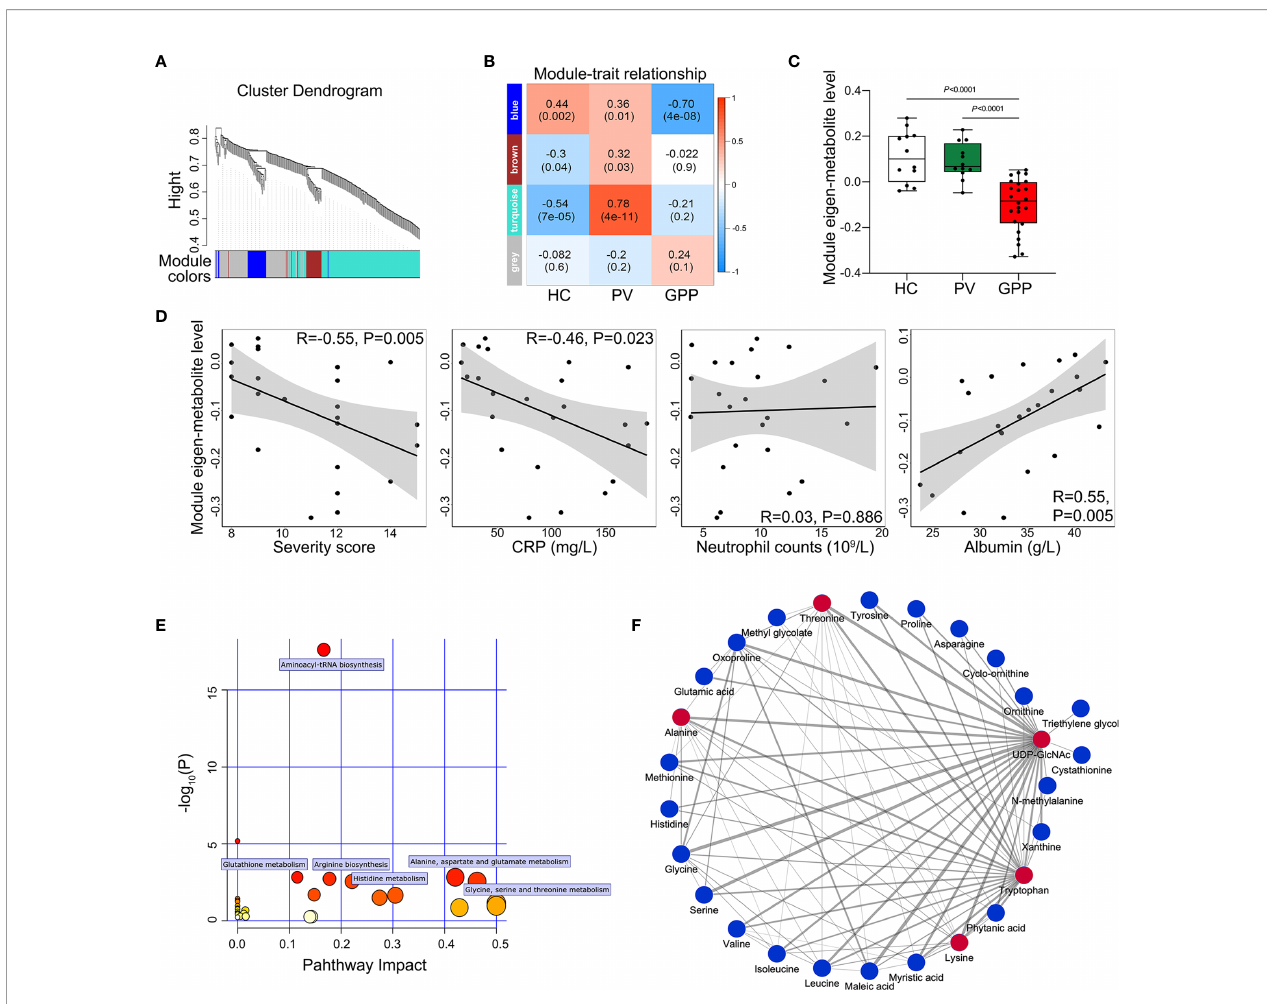
FIGURE 3 | Metabolite co-abundant network analysis. (A) Network cluster dendrogram constructed by hierarchical clustering of the metabolomic dataset. Three network modules were demonstrated in different colors. (B) Heatmap of the correlation between module eigen-metabolites and disease status. The heatmap cell color signi fi ed the correlation coef fi cients (red = positive, blue = negative). In the cells, the fi gure without parentheses showed the correlation coef fi cients. The P -values were indicated below in parentheses. (C) The eigen-metabolite values of blue module separate GPP (n = 24) from both HC (n = 12) and PV (n =12) groups by one way ANOVA. (D) The correlation between blue module eigen-metabolite values and GPP clinical parameters including severity scores, GPP levels, neutrophil counts, and albumin levels, as assessed by Pearson ’ s correlation. (E) Summary of pathway topology analysis of the metabolites within the blue module, with the target pathways being selected and labeled. (F) Network of metabolites within the blue module was constructed by Cytoscape (edge weight > 0.3. The metabolites and connections between them are represented by nodes and edges. The red color indicates the top 5 metabolites with the highest number of connections. Strong connections are visualized as wider